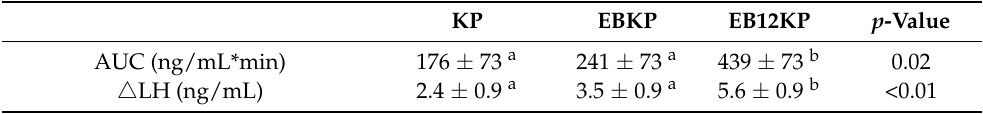
Table 1. Parameters of LH release in ovariectomized Nelore cows treated i.m. with 4 mg murine KISS1-10 (KP); KISS1-10 + i.m. 2 mg estradiol benzoate simultaneously (EBKP); and KISS1-10 +